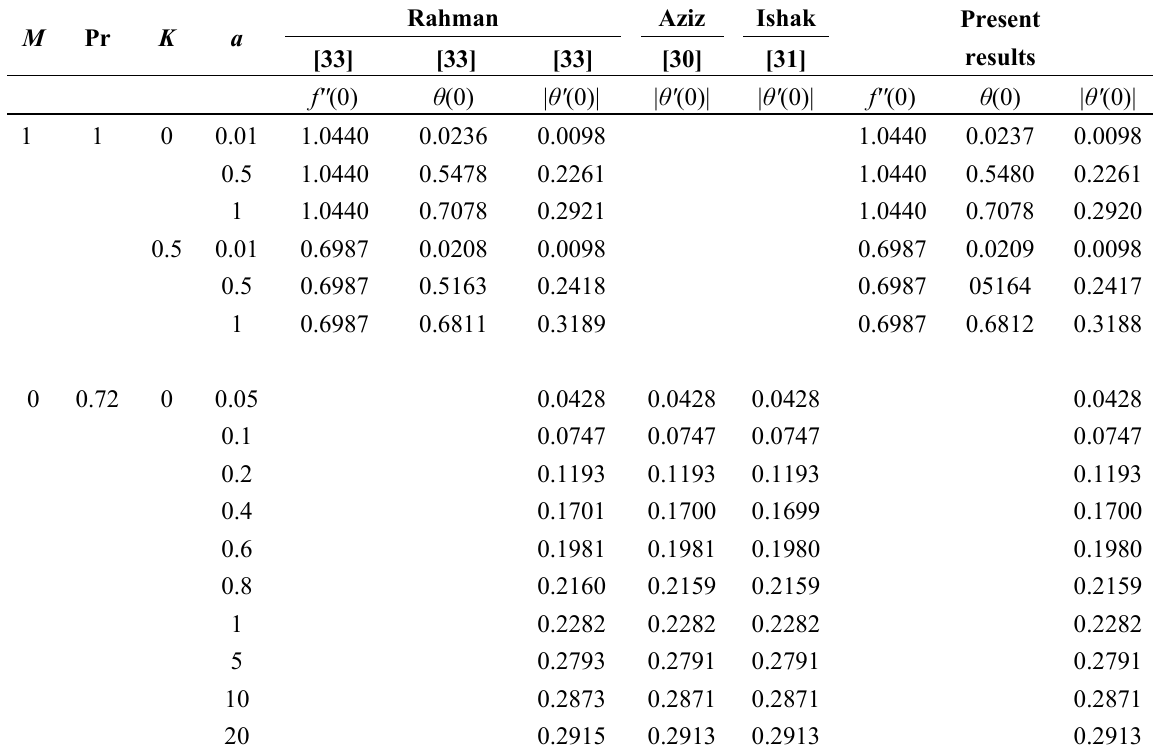
Table 1. Comparison of the velocity gradient at the wall f'' (0), temperature distribution θ (0), and temperature gradient | θ ' (0)| at the wall between the present results and those obtained